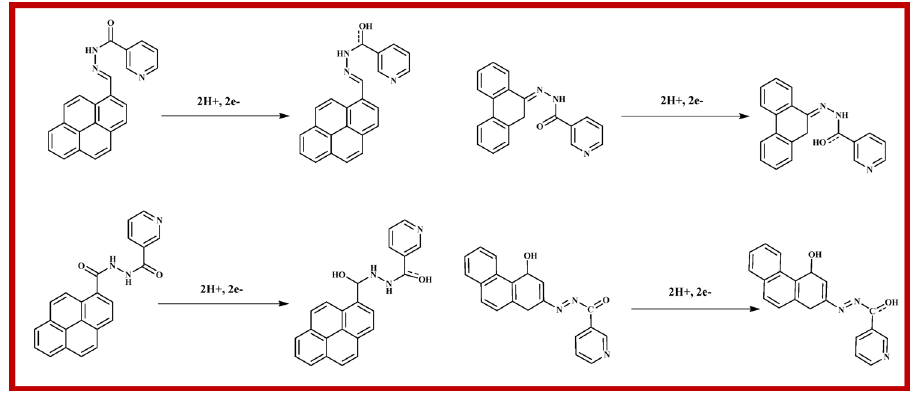
Figure 4. The interactions of NAHGO at pH